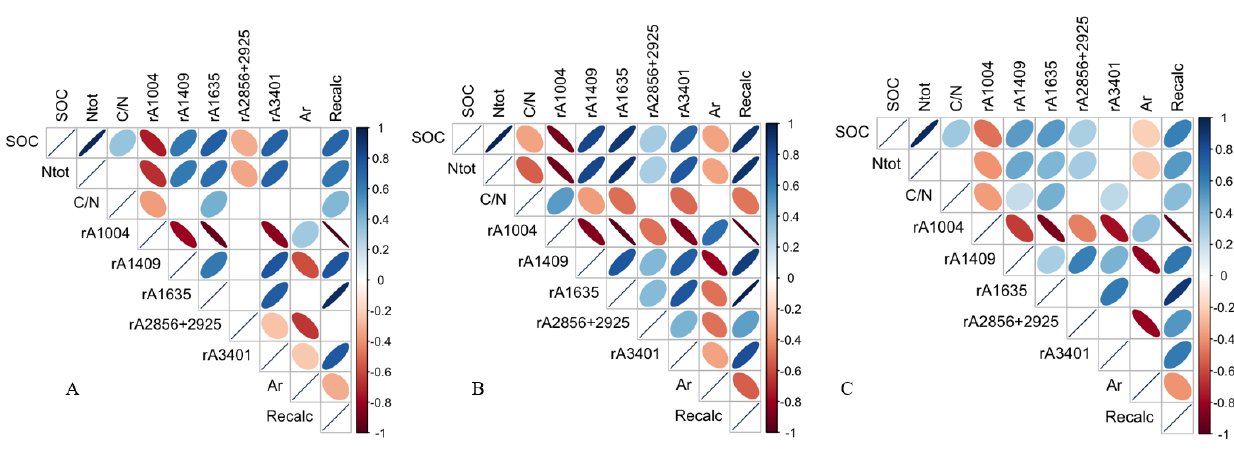
Figure 4. Correlation matrices for ( A ) bulk soil, ( B ) POM, and ( C ) MAOM. Blue ellipses indicate a positive correlation and red a negative correlation. The narrower the ellipse and the more intense its color, the stronger the correlation. The direction of the ellipse depends on the color.